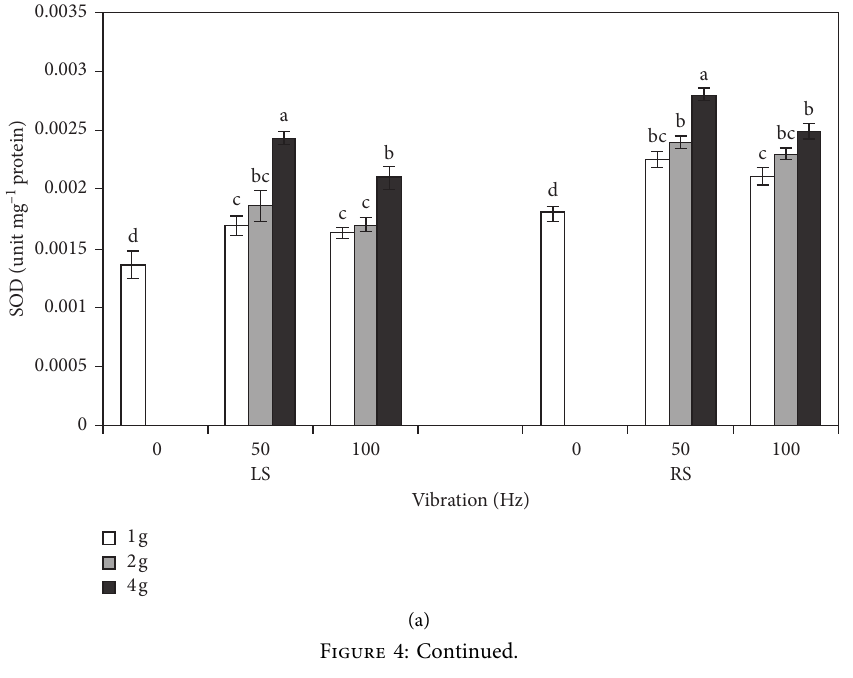
Figure 3: Effect of different sinusoidal vibrations (0, 50, and 100 Hz) and accelerations (1, 2, and 4 g) on H (b) of A. gilanica calli. Bars indicate mean ± SE ( n � 4) in each group. Different letters indicate significant differences at P < 0 . 05